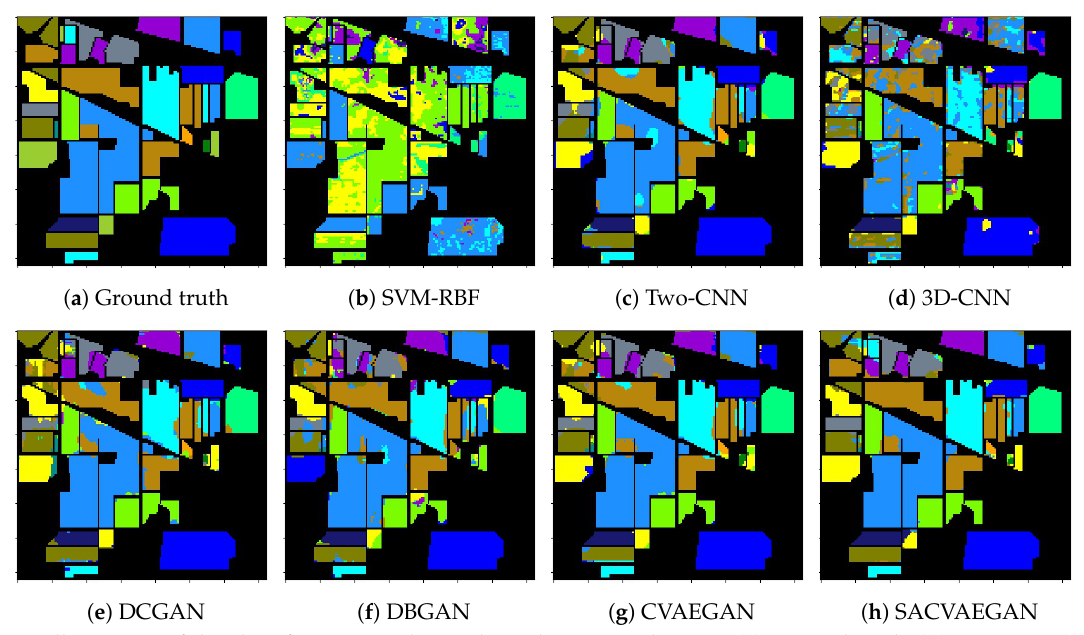
Figure 6. Illustration of the classification results on the Indian Pines data set. ( a ) Ground truth, ( b ) SVM-RBF (51.69%), ( c ) Two-CNN (90.10%), ( d ) 3D-CNN (77.80%), ( e ) DCGAN (91.11%), ( f ) DBGAN (84.42%), ( g ) CVAEGAN (93.47%), and ( h ) SACVAEGAN (95.98%).